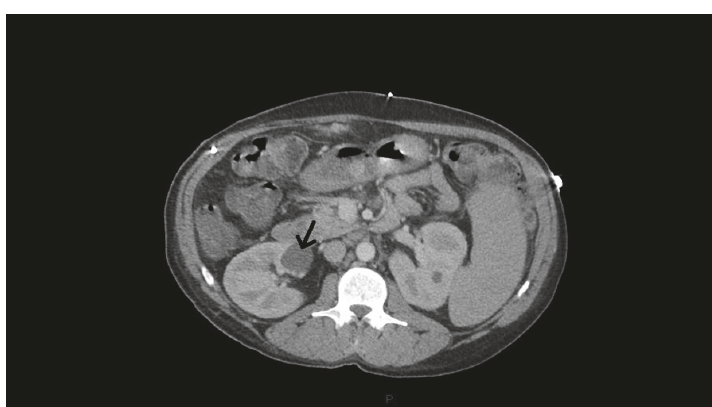
Figure 2: Axial image from CT of the abdomen with IV contrast obtained 65 days prior to admission revealed a simple right renal cyst (black arrow) in the location of the now infected